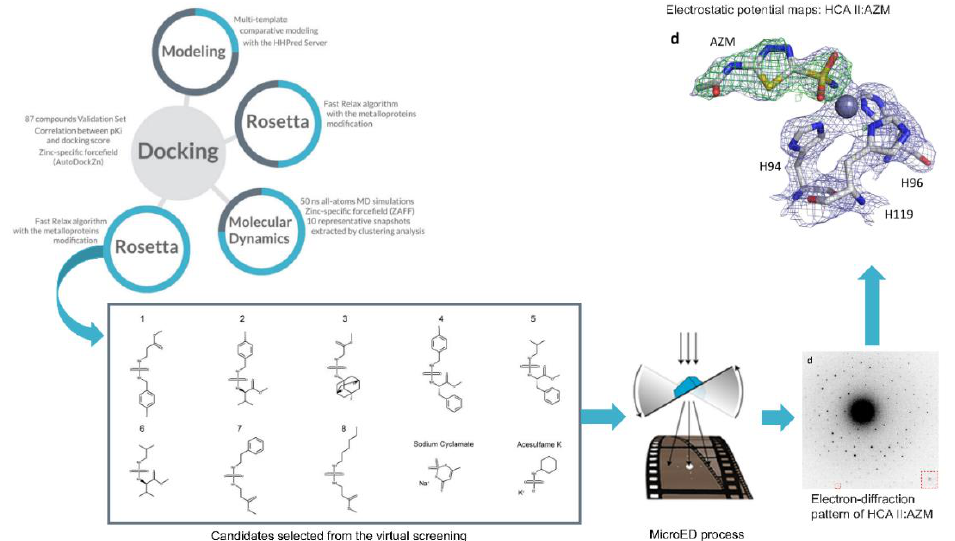
Figure 2. Scheme proposed for coupling the workflow used by Llanos et al. [21] with the MicroED technique applied by Clabbers et al. [39]. For illustrative purposes, the human carbonic anhydrase (hCA) image was used; however, the idea of the scheme is this application for studying TcCA with the inhibitors selected by the workflow proposed by Llanos et al. [21]. The MicroED process illustration is from the work of Nannenga and Gonen [41].